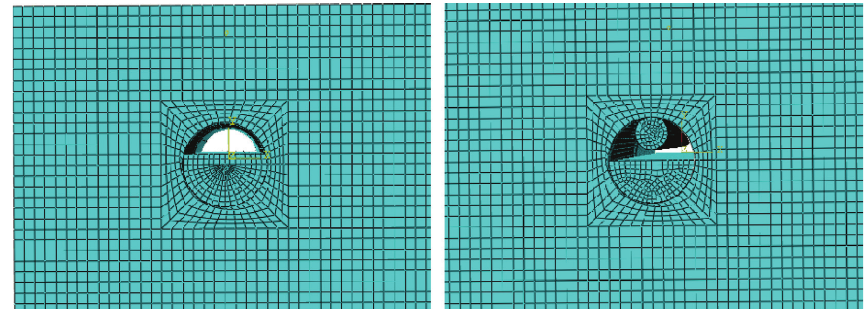
Figure 3: Schematic diagram of the finite element model.